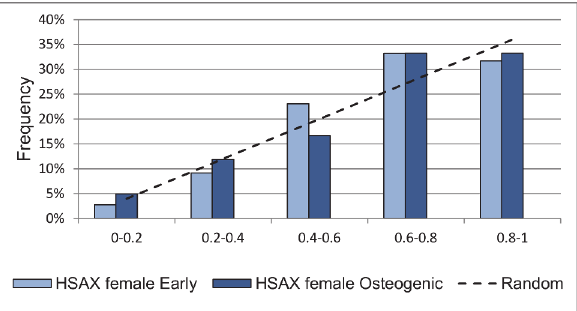
Fig 5. RDCs of HSAX in female cells before and after osteogenic differentiation. RDCs of HSAX in female cells change osteogenic differentiation of MSC (p = 0,04). Dashed line demonstrates random distribution for